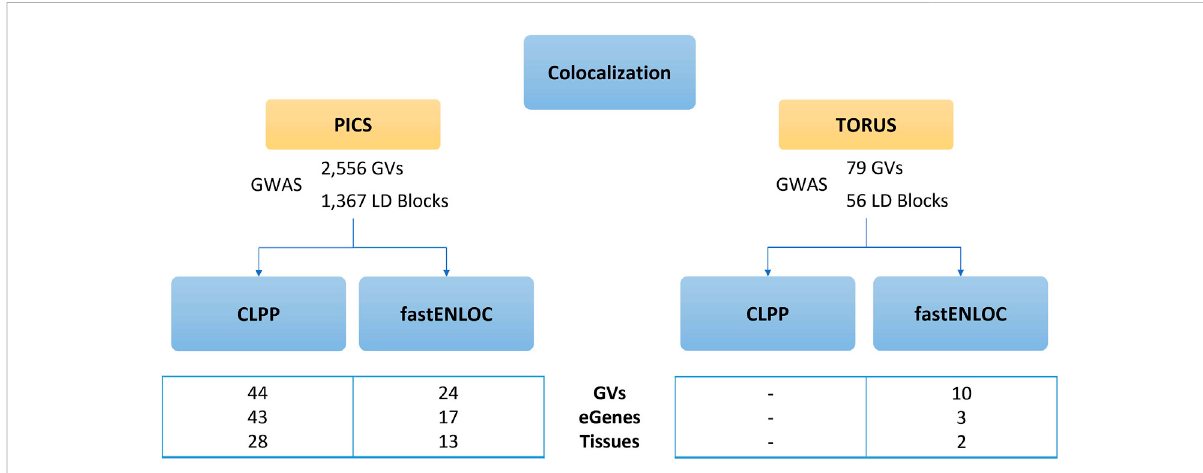
FIGURE 4 Results of CLPP and fastENLOC colocalization analysis. Comparison of CLPP and fastENLOC colocalization outcomes according to the prior fi ne-mapping tool used. CLPP, Colocalization Posterior Probability; fastENLOC, Fast Enrichment Estimation Aided Colocalization Analysis; GVs, genetic variants; eGenes, genes regulated by an expression quantitative trait loci.